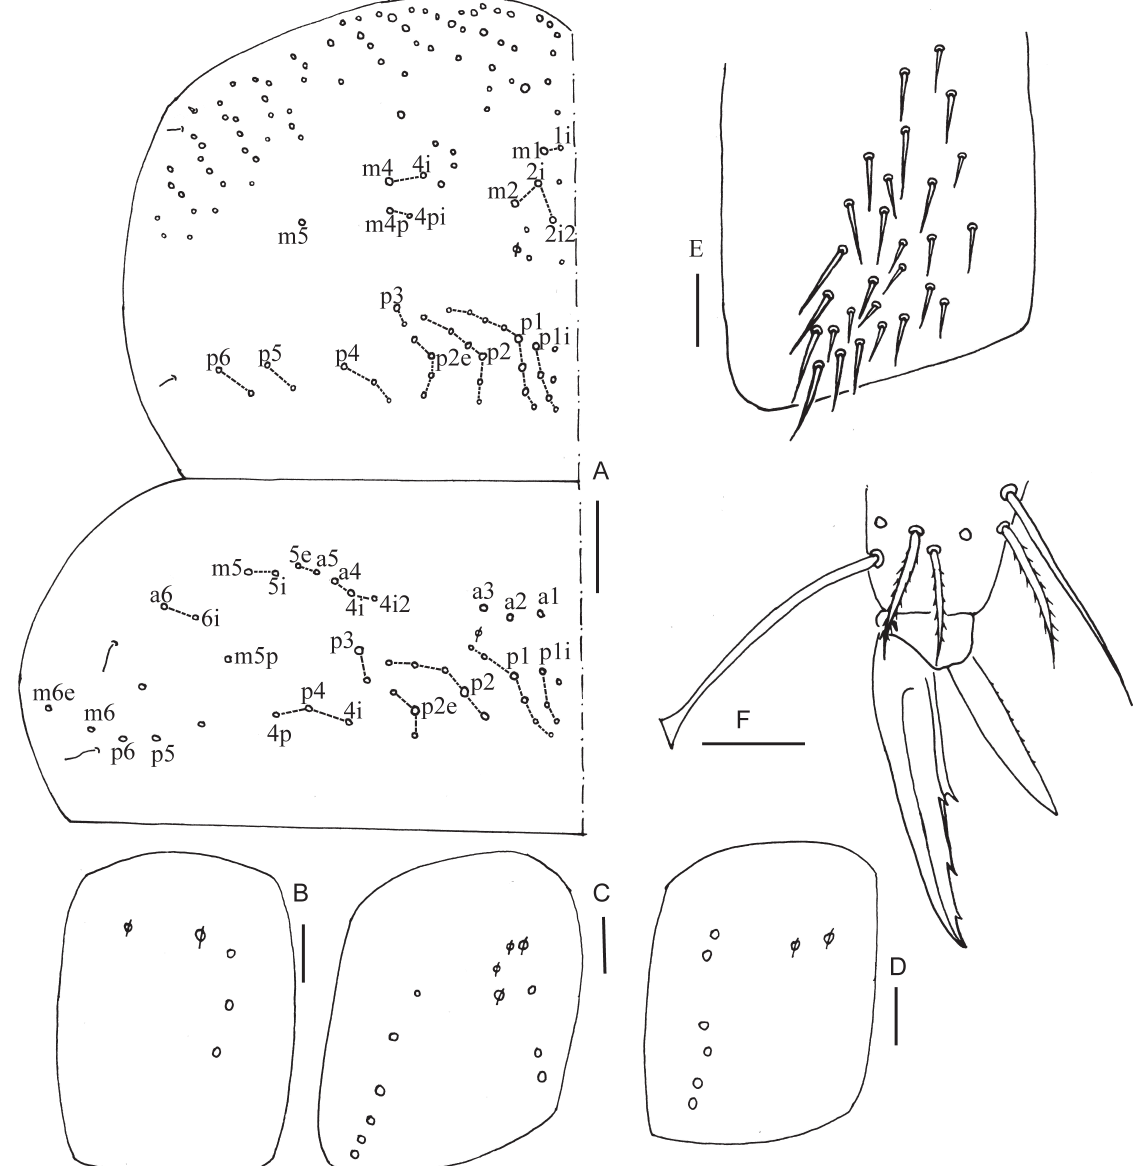
Fig. 8. Entomobrya polychaeta sp. nov. A . Chaetotaxy of Th. II−III. B . Coxal macrochaetal formula of fore leg. C . Coxal macrochaetal formula of middle leg. D . Coxal macrochaetal formula of hind leg. E . Trochanteral organ. F . Hind foot complex. Scale bars: A = 50 μm; B–F = 20